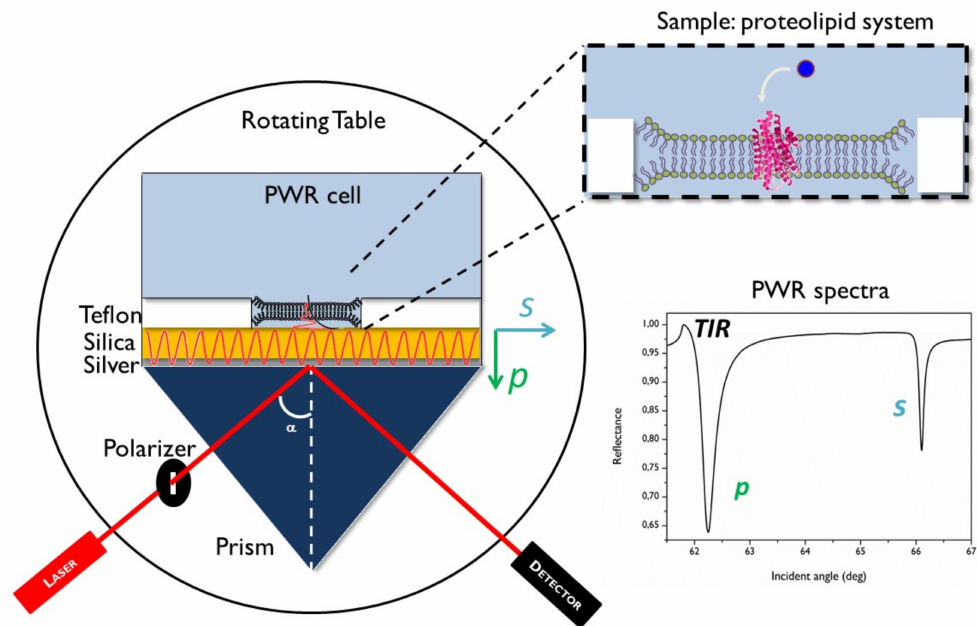
Figure 1. PWR setup. Optical and mechanical components (left)—the incident polarized light beam (a continuous He − Ne laser at 632.8 or 545 nm) and the rotating table allow steps of 1 mdeg. The sensor consists of a right-angle BK7 prism coated with a 50 nm layer of silver, overcoated by 460 nm of silica. Polarized light s - (parallel) and p - (perpendicular) are defined relative to the sensor surface. A proteolipid system is depicted as an example of a sample (insert top right). On the right bottom is a typical PWR spectra showing the total internal reflection angle (TIR) and p - and s